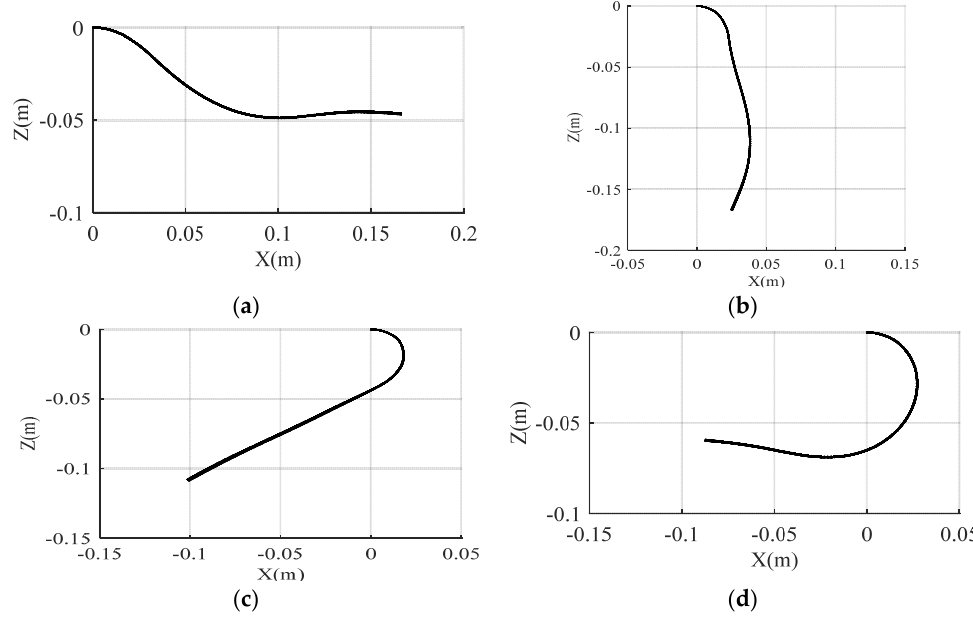
Figure 8. The shapes of the silicone plate at different moments. ( a ) t = 0.1 s, ( b ) t = 0.2 s, ( c ) t = 0.3 s, ( d ) t = 0.4 s.